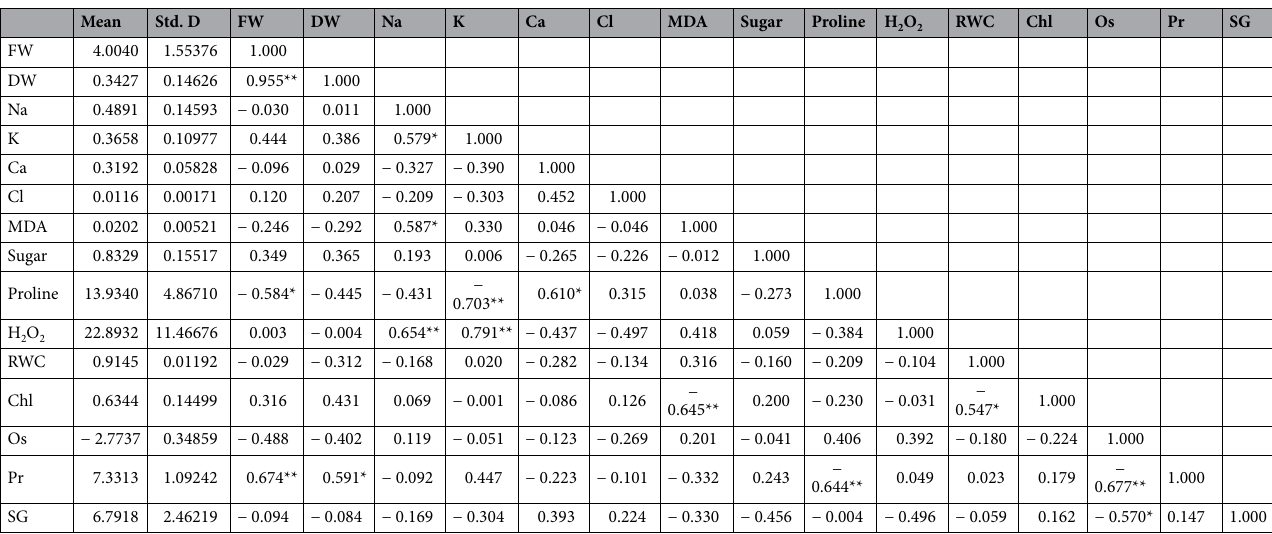
Table 1. Correlation analysis between fresh weight (FW) and other 14 indicators including dry weight (DW), Na + (Na), K + (K), Ca 2+ (Ca), Cl − (Cl), MDA, soluble sugars (Sugar), proline (Proline), hydrogen peroxide (H 2 O 2 ), relative water content (RWC) and chlorophyll contents (Chl), osmotic potential (Os), photosynthetic rate (Pr), and salt gland density (SG) using Pearson correlation analysis. **Correlation is significant at the 0.01 level (2-tailed). *Correlation is significant at the 0.05 level